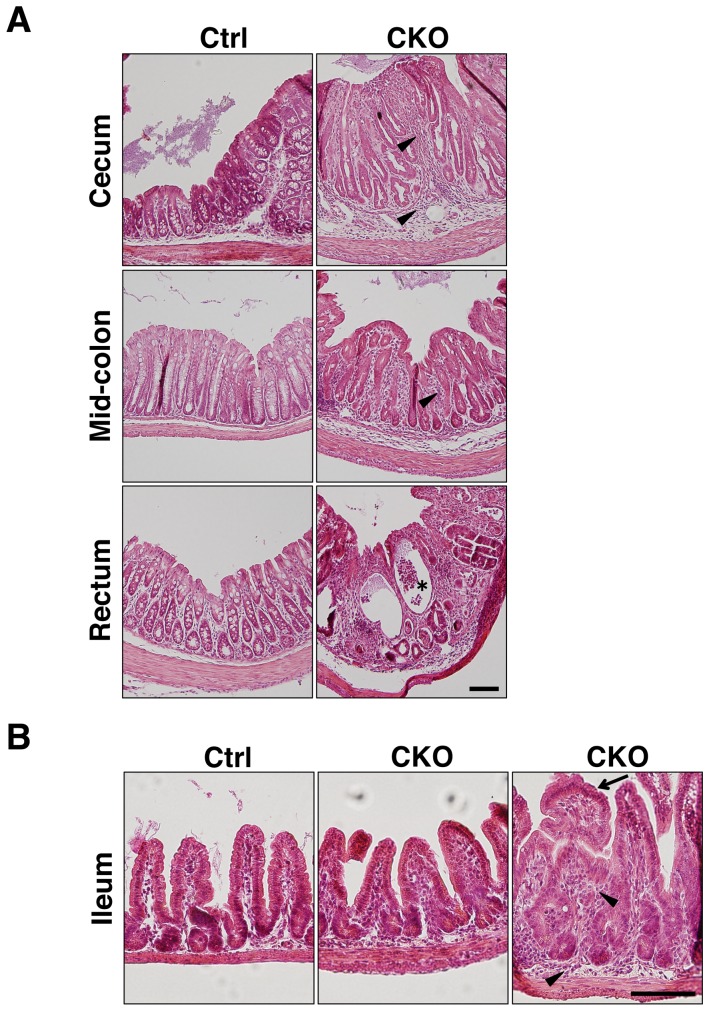
Spontaneous development of marked inflammation in the colon of Shp2 CKO mice.
A: Hematoxylin-eosin staining of paraffin-embedded sections of the cecum, mid-colon, and rectum from control or Shp2 CKO mice at 3 weeks of age. Arrowheads and the asterisk indicate inflammatory infiltrates and a crypt abscess, respectively. B: Hematoxylin-eosin staining of the ileum from control and Shp2 CKO mice at 3 weeks of age. Arrowheads and the arrow indicate inflammatory infiltrates and abnormal villus structure, respectively. All data are representative of three separate experiments. Scale bars, 100 μm.